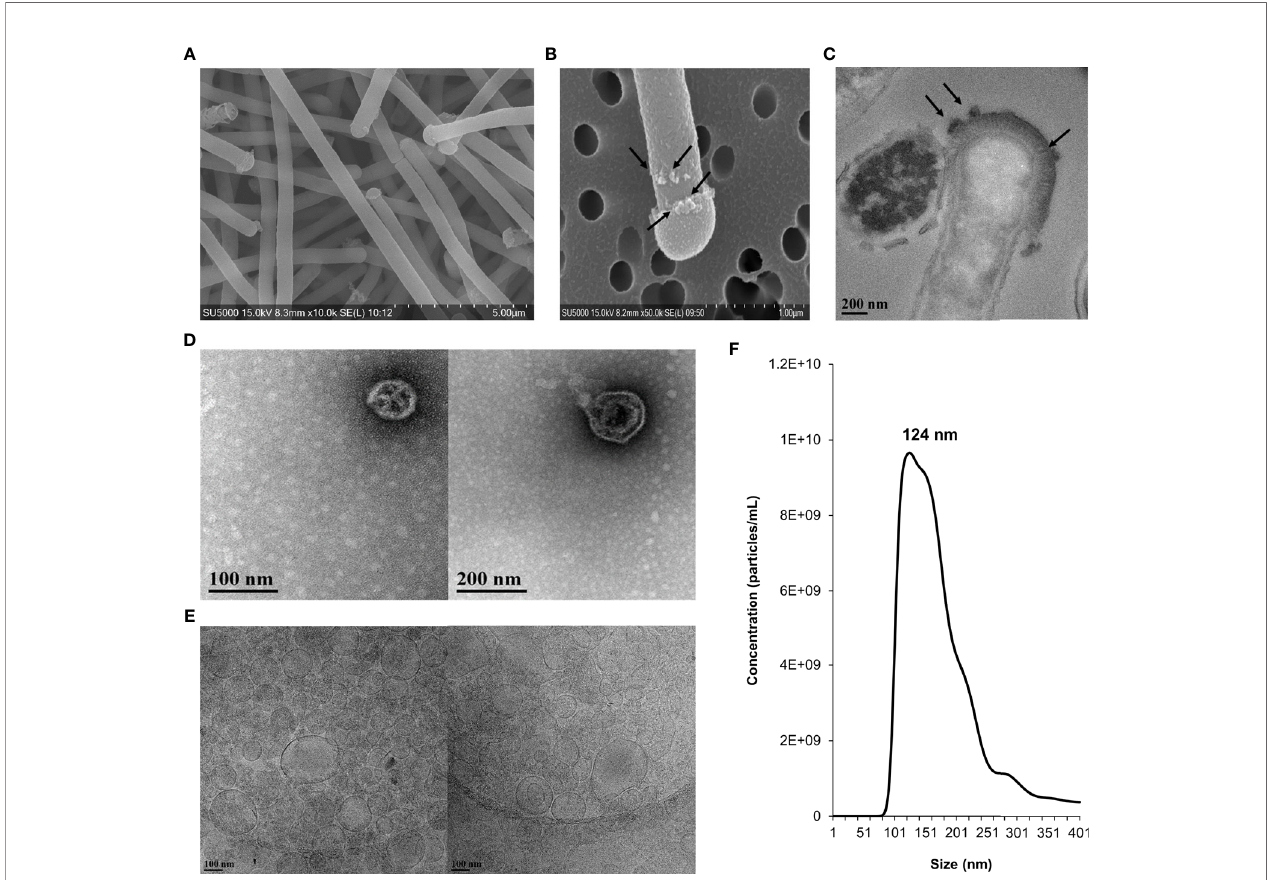
FIGURE 1 | Morphological characterization, size distribution and concentration of NV in L. johnsonii N6.2. Whole cells and NV were imaged under electron microscopy and quanti fi ed by NanoSight. (A) SEM image showing L. johnsonii N6.2 cells. (B) SEM and (C) TEM images depicting the production of NV on the surface of the whole cell and cap structure on the terminal end of the bacterium. Black arrows point to the NV formations. (D) TEM and (E) Cryo-TEM (right) images of the morphological characteristics of the puri fi ed NV. (F) Nanoparticle tracking analysis was conducted using Nanosight